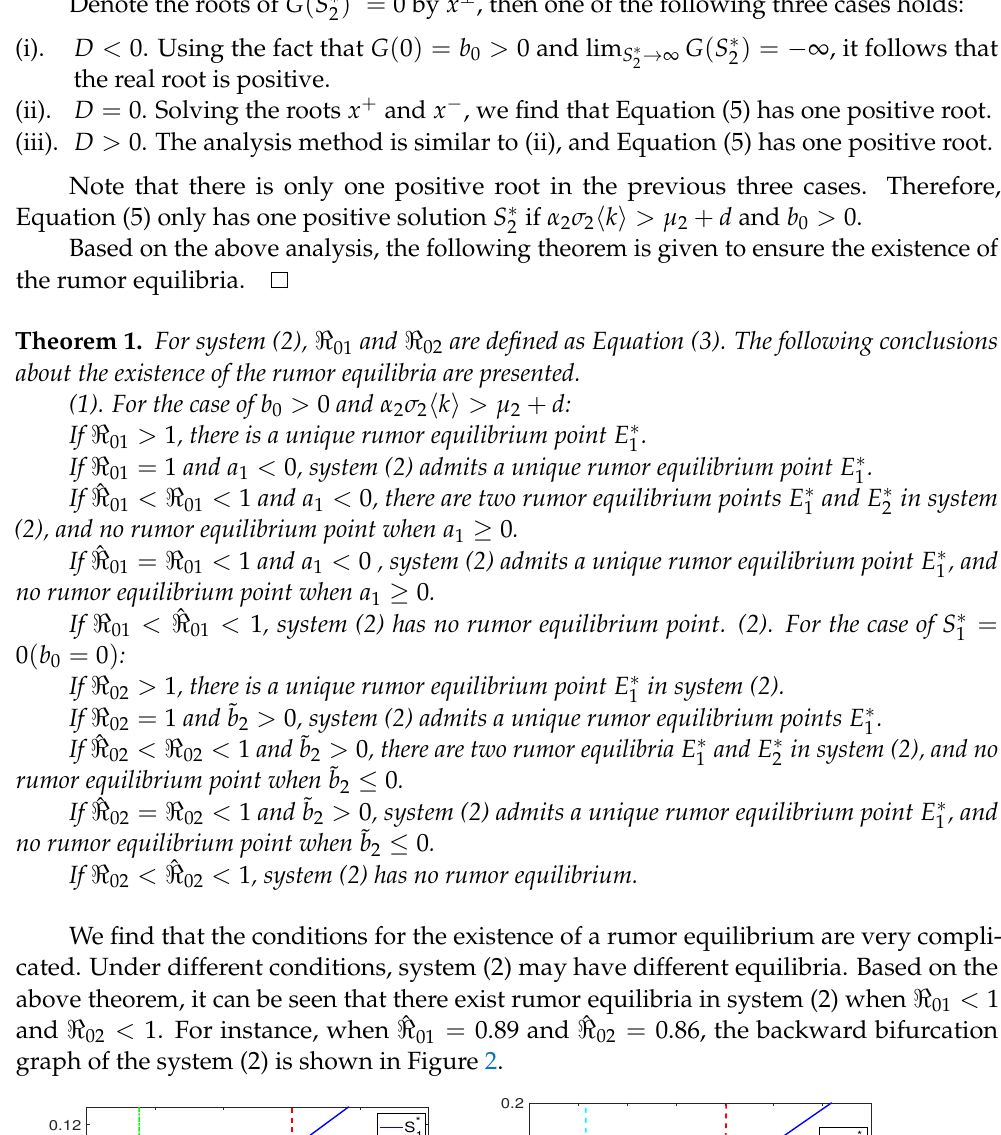
and the basic reproduction number (cid:60) 01 . ( b ) The 1 and the basic reproduction number (cid:60) 02 2